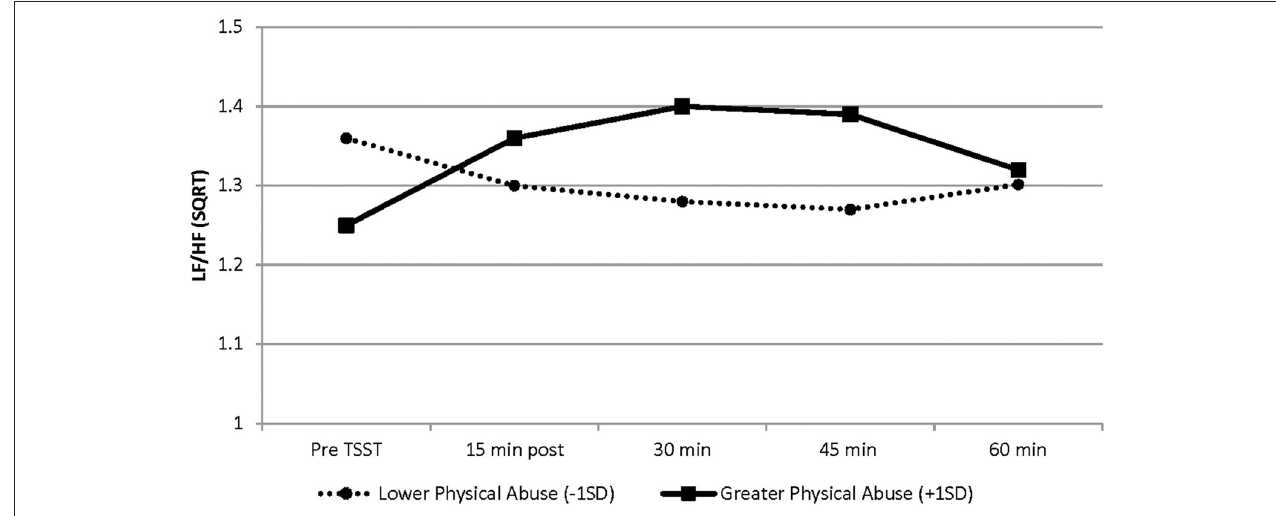
FIGURE 1 | Graphical representation of the effects of physical abuse on LF/HF-HRV from baseline (before TSST) to 60min post TSST. These effects are modeled as ± 1 SD of the sample mean values on the physical abuse subscale. Greater exposure to physical abuse was associated with a steeper rise in the linear slope (b = 0.0086, SE = 0.0024, p = 0.001) and greater curvature of the quadratic slope (b = − 0.00012, SE = 0.00003, p = 0.001). Solid line represents physical abuse subscale scores at + 1 SD; dashed line represents physical abuse subscale scores at − 1 SD. Graphs are estimated by the hierarchical linear models from baseline (before TSST) to 60min post TSST. N = 34. SD, standard deviation; SE, standard error.